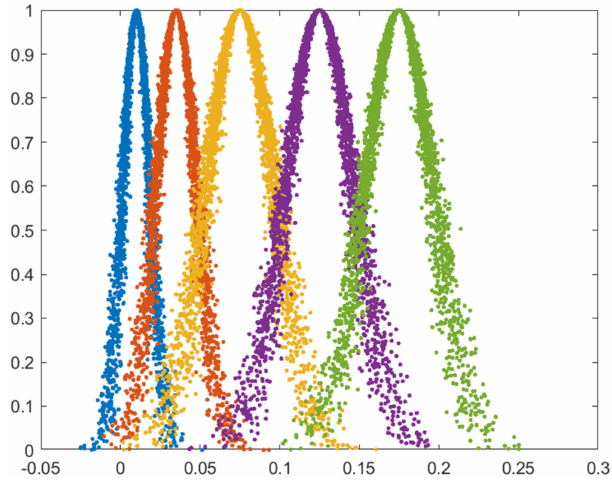
Figure 8. Logistics industry as a percentage of fixed asset investment cloud model.